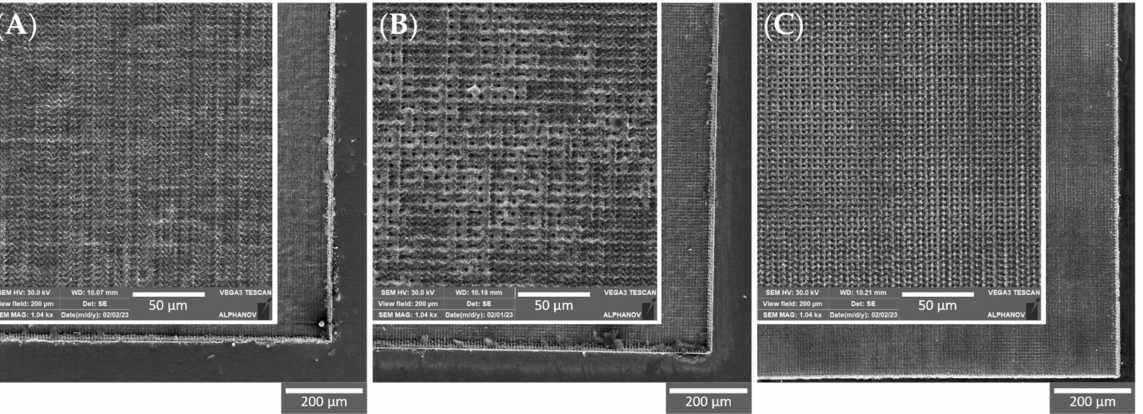
Figure 6. Laser surface structuring of stainless steel material. Insets show close-up views of structure bottoms, while the larger images allow for structure edge evaluation. Laser parameters shown are the following: ( A ) 1 ns pulse duration, 3 µ J pulse energy; ( B ) 2 ns pulse duration, 2 µ J pulse energy; ( C ) 4 ns pulse duration, 1 µ J pulse energy. Structure depth decreases from A to C, while bottom roughness is smallest for